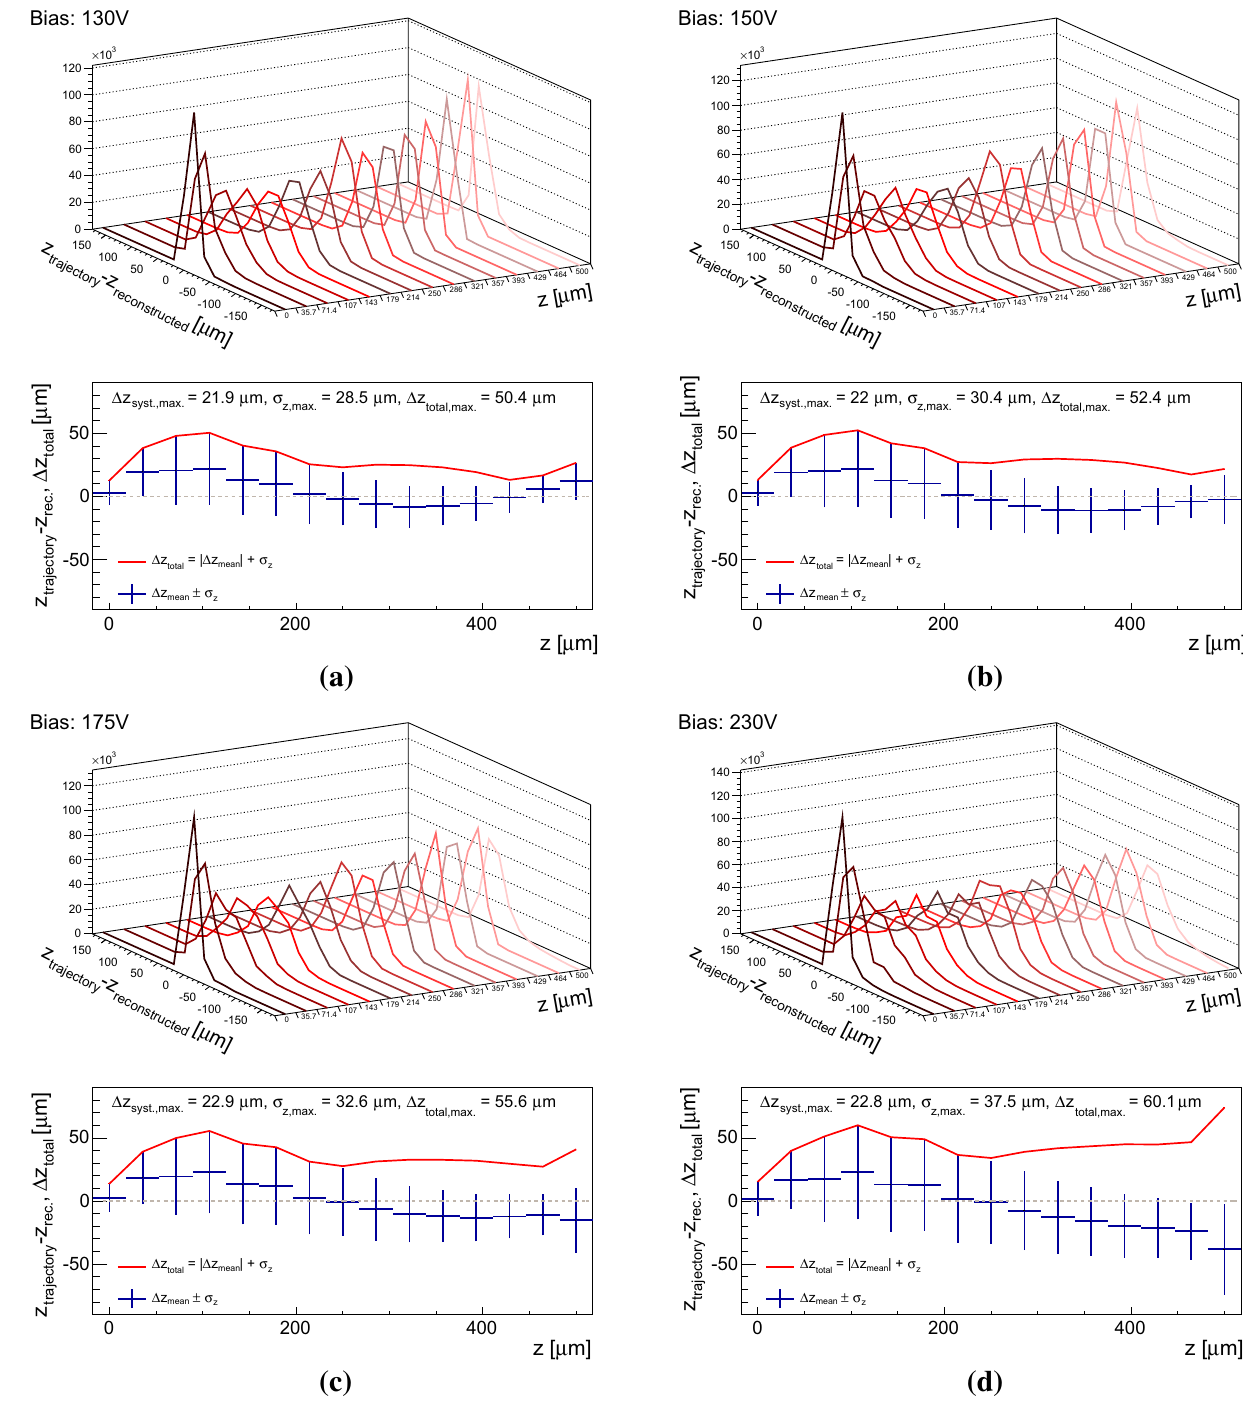
Fig. 8 Depth dependent study of the deviations of the reconstructed from the “real” z -coordinate ( upper plots ) and the z -resolutions as defined in the text ( lower plots ) for the investigated bias voltages: 130V ( a ), 150V ( b ), 175V ( c ), and 230V ( d )